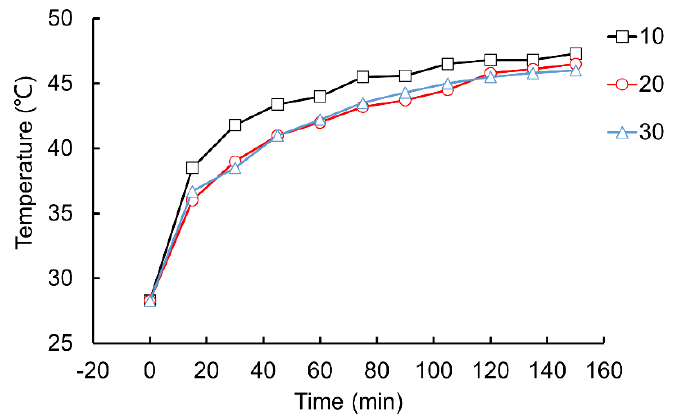
Figure 15. Effect of preload torque of Junction Surface at Straight Edge Knife on Temperature of Acoustic Vibration Component.